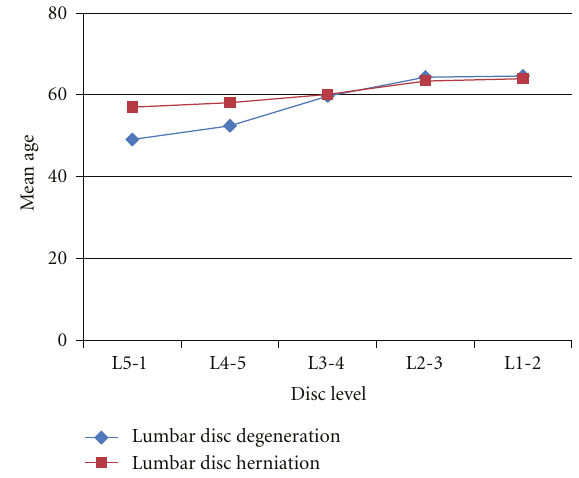
Figure 2: Lumbar disc herniation and lumbar disc degeneration versus age. The numbers in the figure correspond to di ff erent mean ages ( ± SEM) with respect to disc herniation and degeneration lev- els. The level of lumbar disc herniation and degeneration increased with